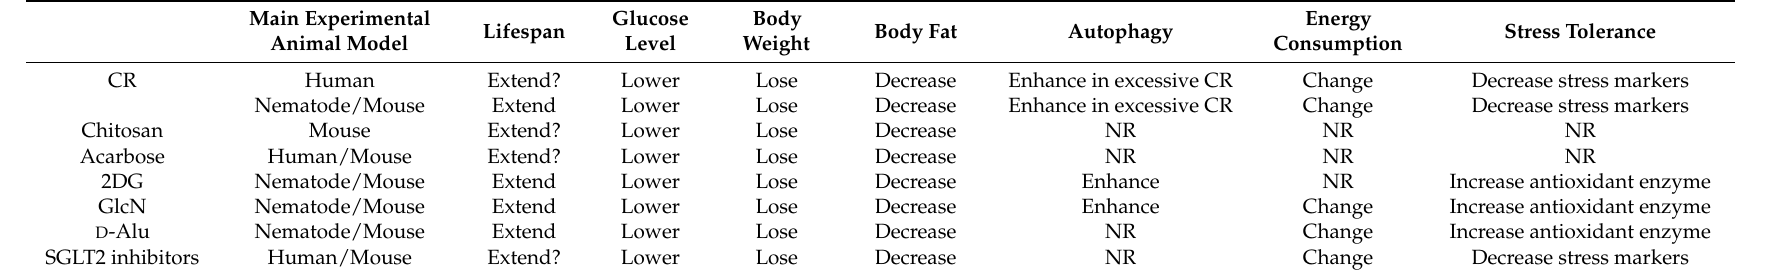
Table 3. Commonalities between CR and upstream-type